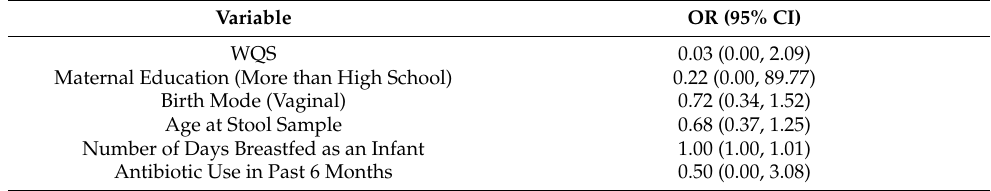
Table 4. Estimates of association with body mass index (BMI), shown as odds ratios from the Weighted Quantile Sum regression with Random Subsets and Repeated Holdouts analysis. The weighted quantile sum (WQS) variable represents the estimate for the association between the gut microbiome mixture and BMI. Odds ratios with confidence intervals (CIs) that do not cross 1.0 are considered statistically significant. Data come from the Growth and Obesity Cohort Study.